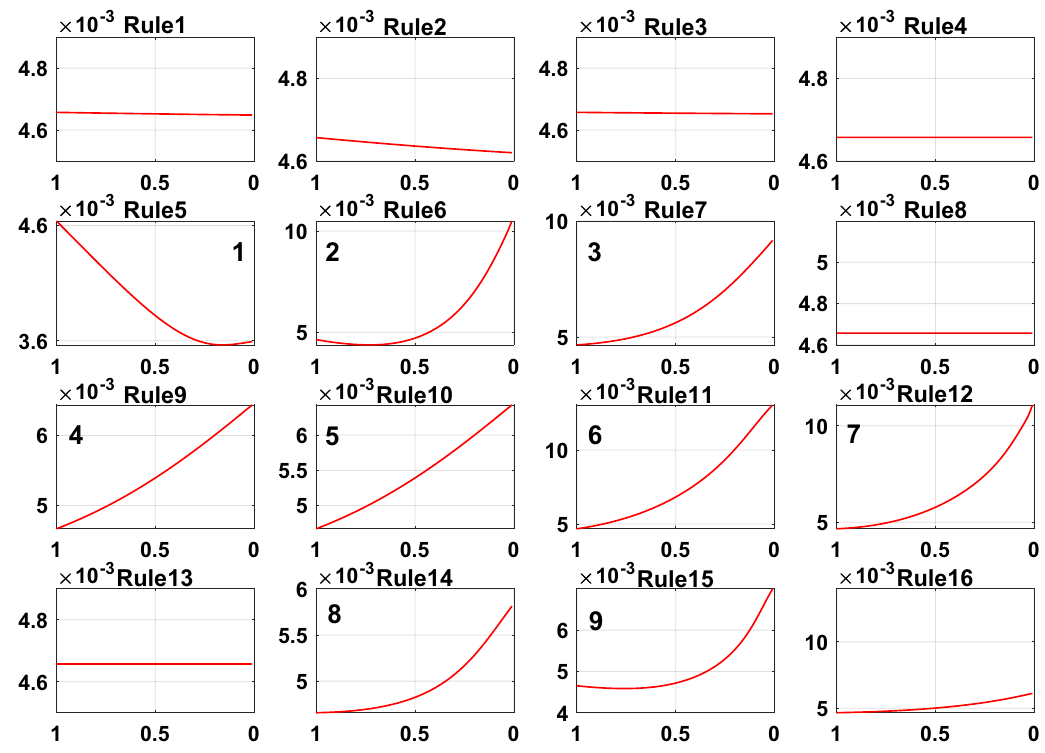
Figure 11. The sensitivity analysis for Sub-BRB3 (x-axis represents rule weights, y-axis represents MSE).